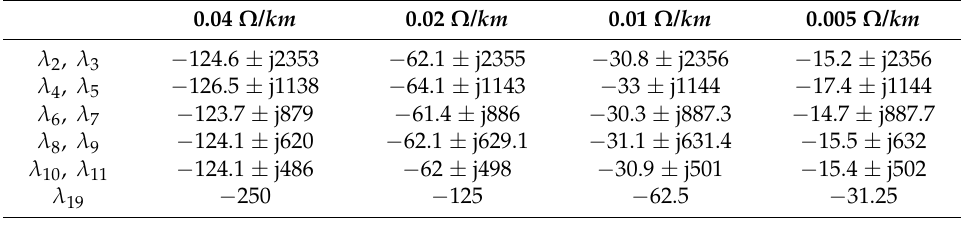
Table 2. Influence of the DC Resistance of MTDC Cables.